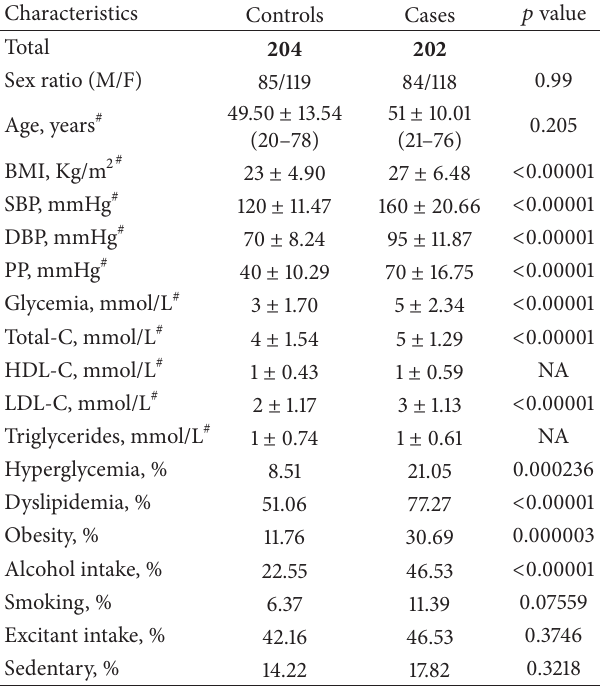
Table 1: General characteristics of study population (cases versus